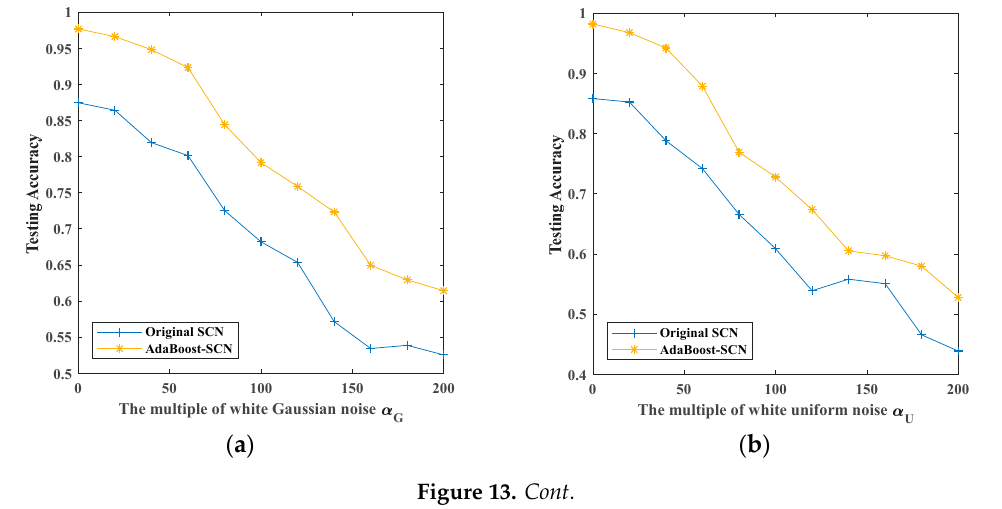
and 0.8925 of noiseless signals to 0.5463, 0.6507, and 0.6881 when the multiple of noises is 200.